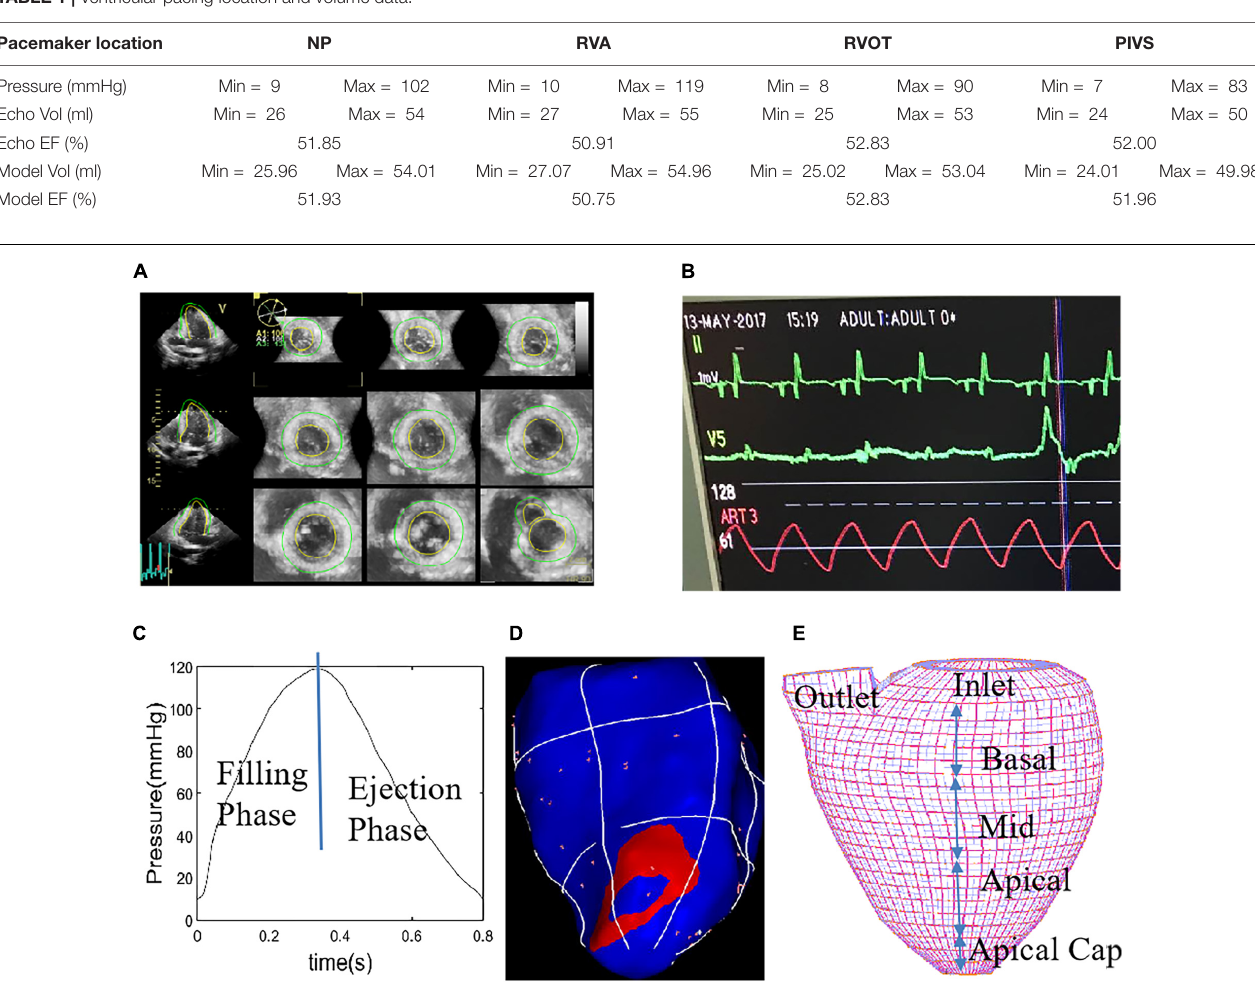
TABLE 1 | Ventricular pacing location and volume data.